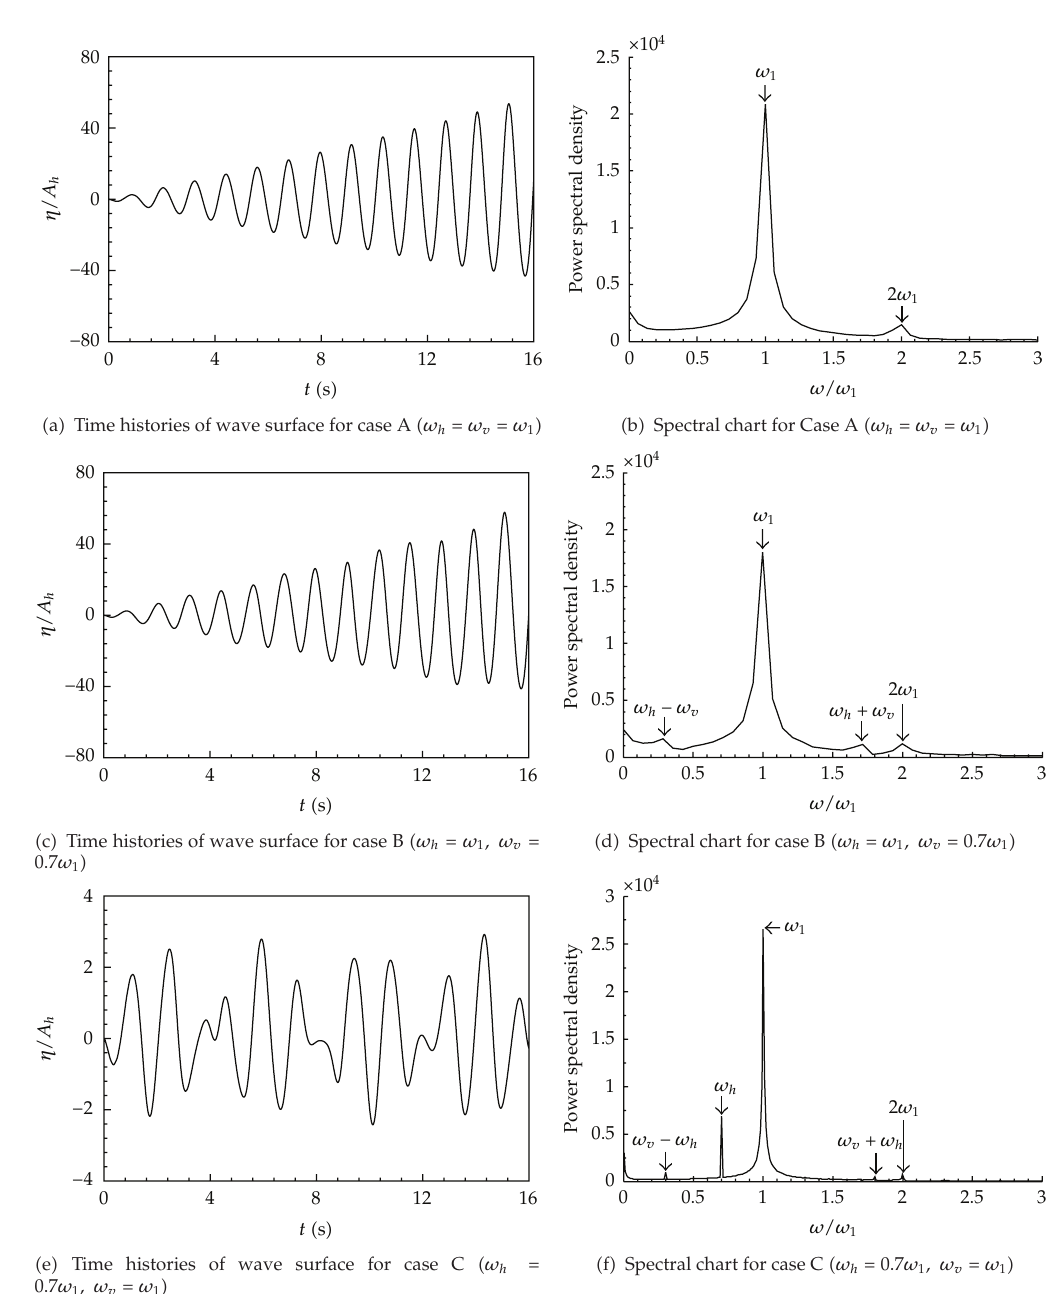
Figure 9: Time histories of wave surface at the left tank wall and the corresponding spectral charts.